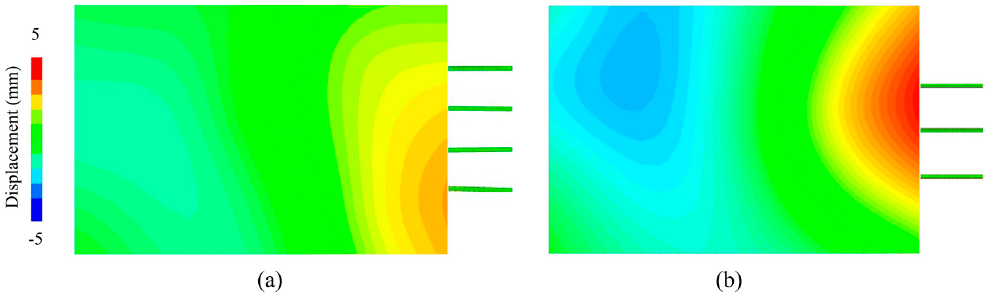
Figure 13. Vertical displacement of surcharge block after pullout: ( a ) biaxial geogrid and ( b ) triaxial geogrid .